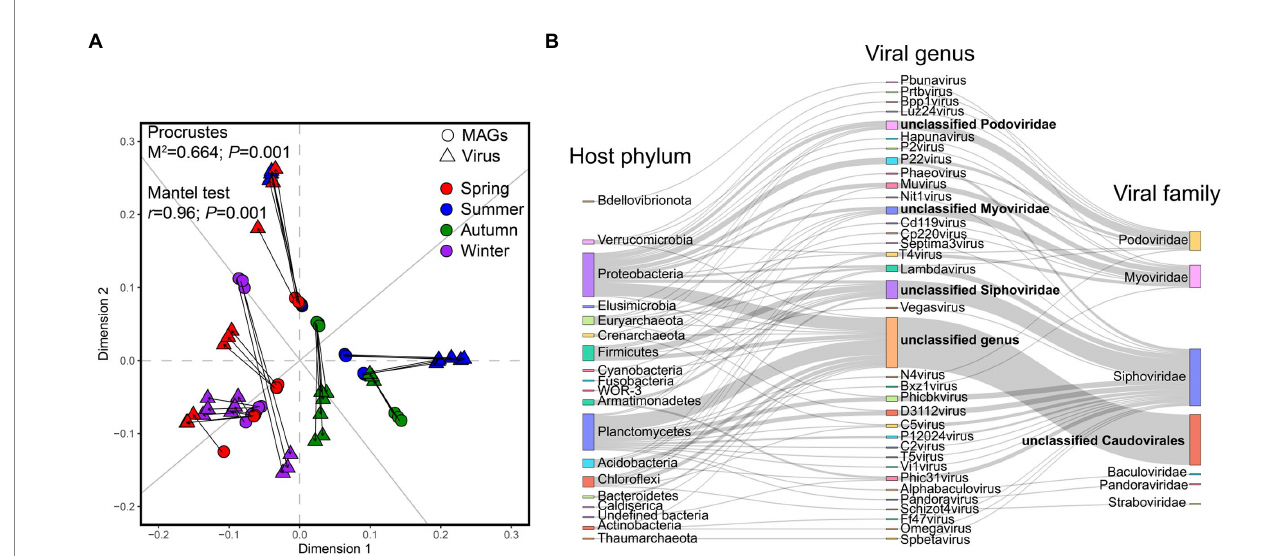
FIGURE 7 Correlation between the viruses and recovered MAGs. (A) Procrustes analysis shows the correlation between the abundance of viral community and the abundance of nitrogen-related genes. Both the Procrustes test and the Mantel test are used for evaluating whether the association is significant and p < 0.05 is considered a significant correlation. (B) Sankey diagram shows the linkages of viral sequences and the hosts based on CRISPR-Cas and genomic similarity blasting with